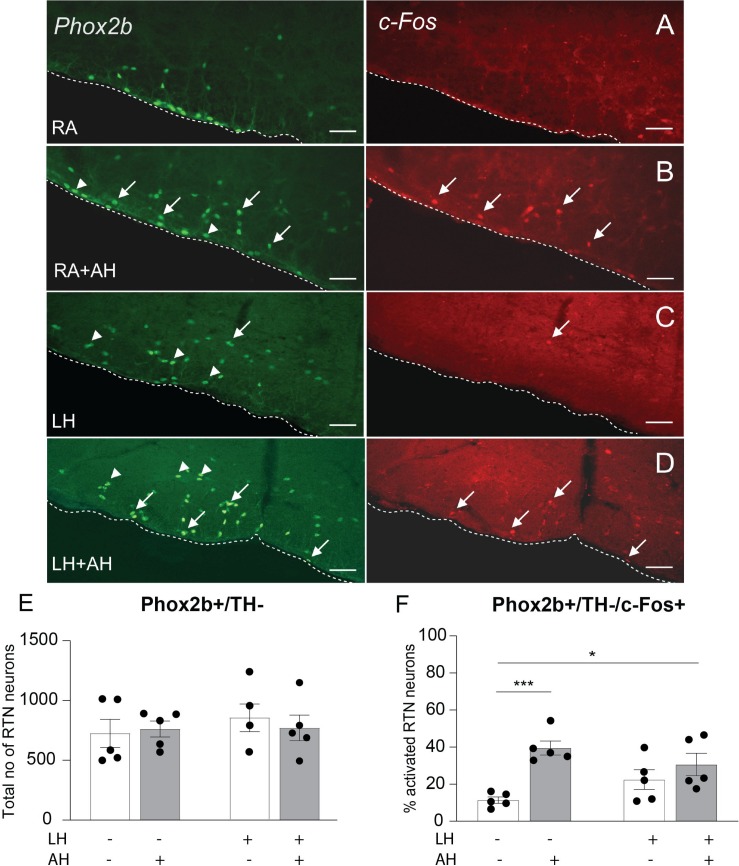
RTN neurons retain their responsiveness to acute hypercapnia chemoreflex challenge following long-term hypercapnia. Representative image of a coronal brainstem section from the RTN region for each experimental group immunostained for Phox2b (green) and c-Fos (red), (A) room air (RA) control, (B) room air + acute hypercapnia chemoreflex challenge (RA + AH), (C) long-term hypercapnia (LH), (D) long-term hypercapnia + acute hypercapnia chemoreflex challenge (LH + AH). Arrowheads point to non-activated RTN neurons; arrows point to activated RTN neurons. Scalebars are 25 μm. (E) The total number of RTN neurons (Phox2b+ /TH−) per mouse. (F) The percentage of activated RTN neurons following different experimental conditions. ∗p < 0.05, ∗∗∗p < 0.001 (Two-Way ANOVA, Multiple comparisons: Sidak).